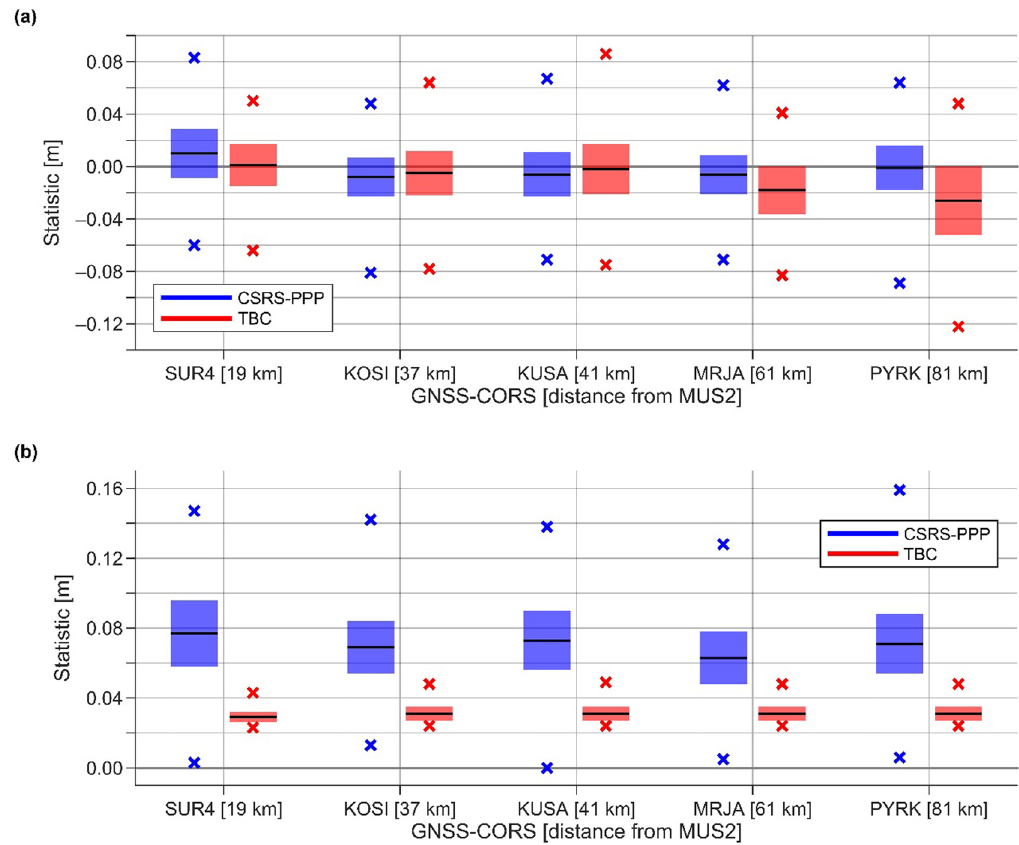
Figure 8: Statistical properties of ( a ) height di ff erences between the o ffi cial CORS heights and the CSRS - PPP and TBC height solutions postprocessed in the kinematic mode, and ( b ) the a priori accuracies of these postprocessing solutions. The black lines are mean values, and colored bars denote standard deviation estimates. Crosses denote minimum and maximum